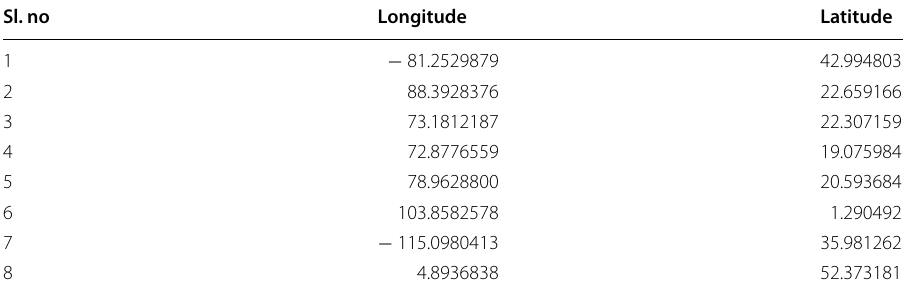
Table 1 Natural disasters in India imported tweets longitude and latitude information Sl. no